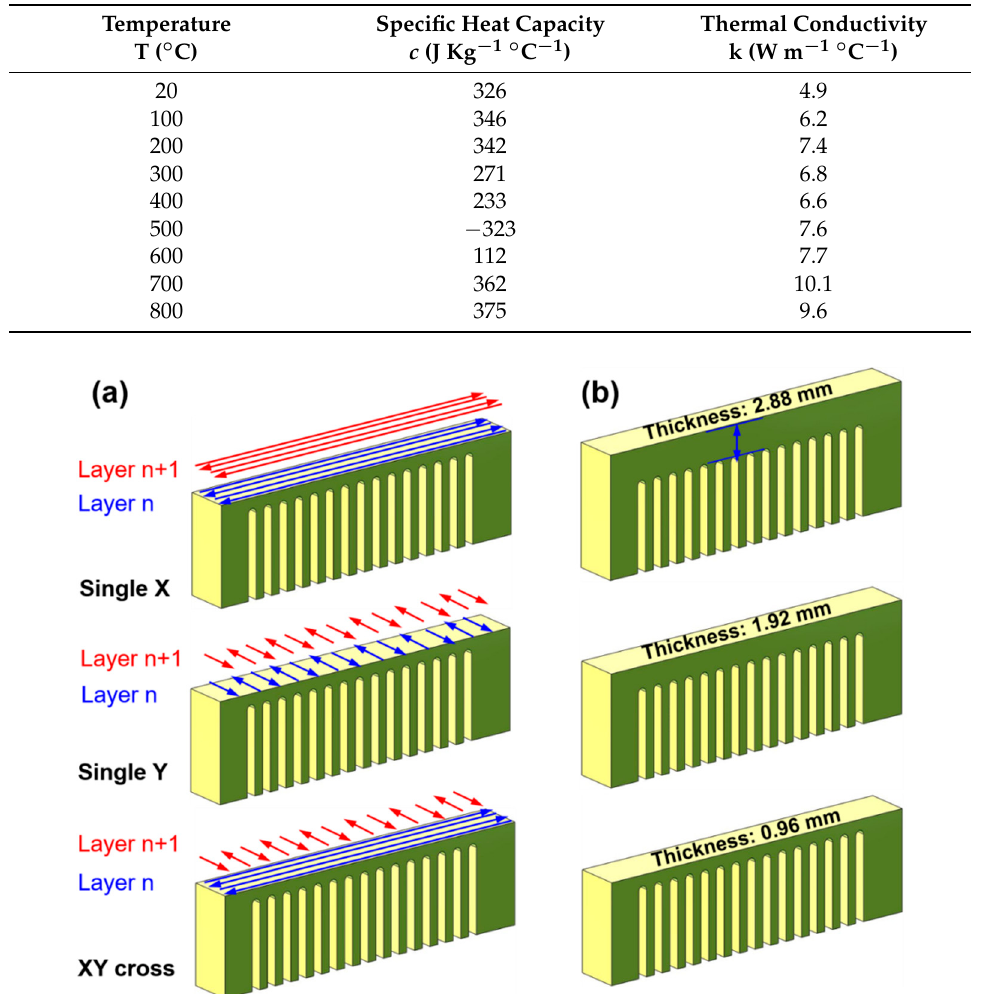
Figure 2. Schematic diagram of different ( a ) laser scanning strategies and ( b ) bar